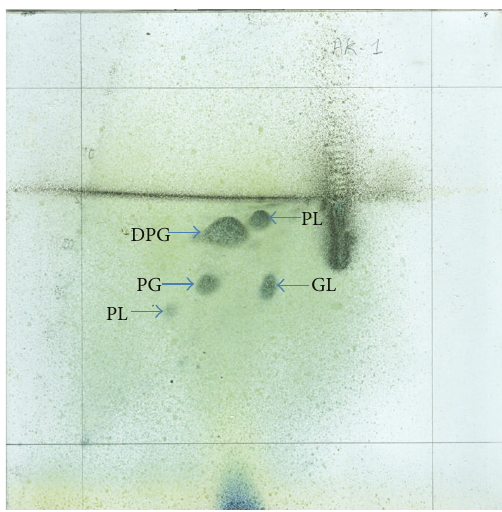
Figure 2: Two-dimensional thin layer chromatograms of the total lipids of strain AK-1 T , detected with molybdophosphoric acid (5% w/v) in absolute ethanol. Phosphatidylglycerol (PG), diphos- phatidylglycerol(DPG),unknownphospholipid(PL),andunknown glycolipids